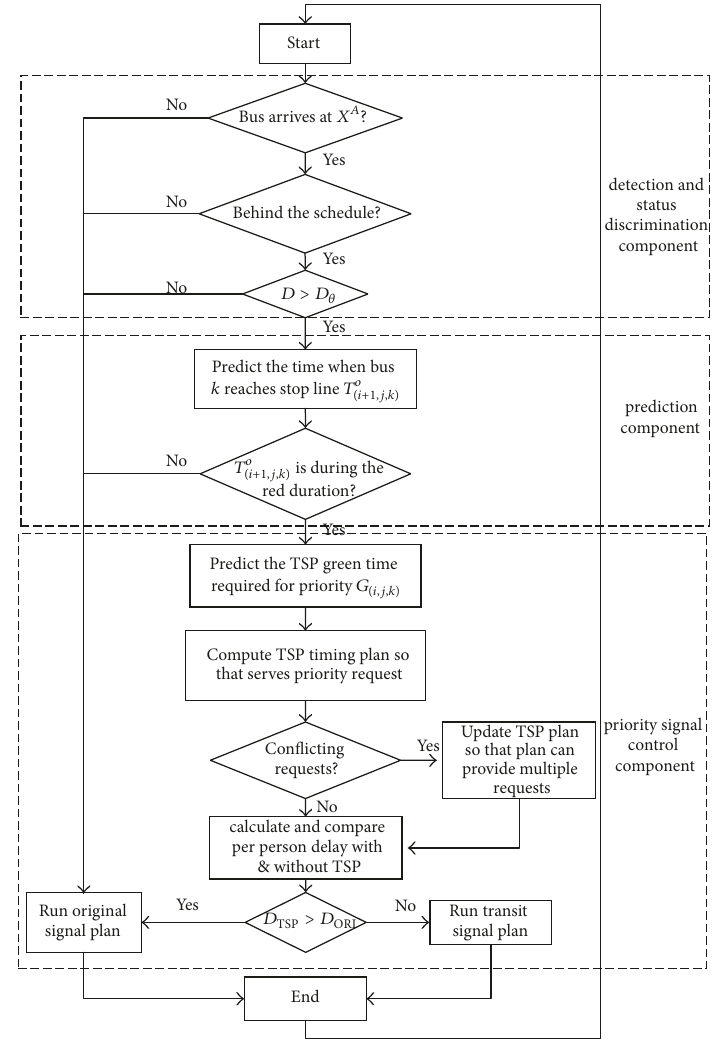
Figure 2: Logical